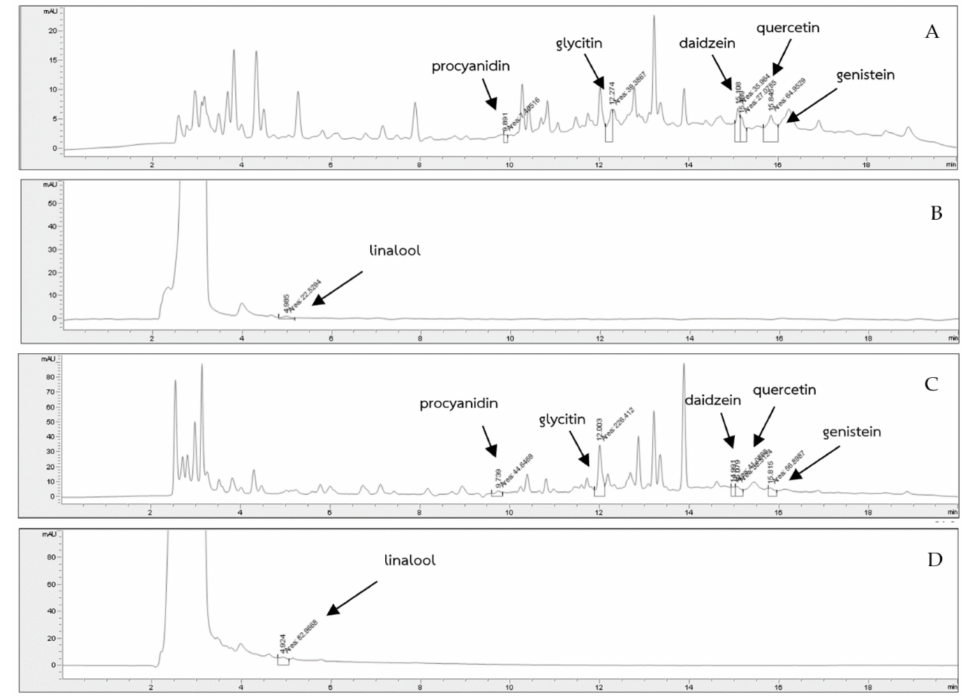
Figure 2. HPLC chromatogram of phenolic compounds in crude GSP extracts ( A , B ) and GSP-fortified green soybean milk ( C , D